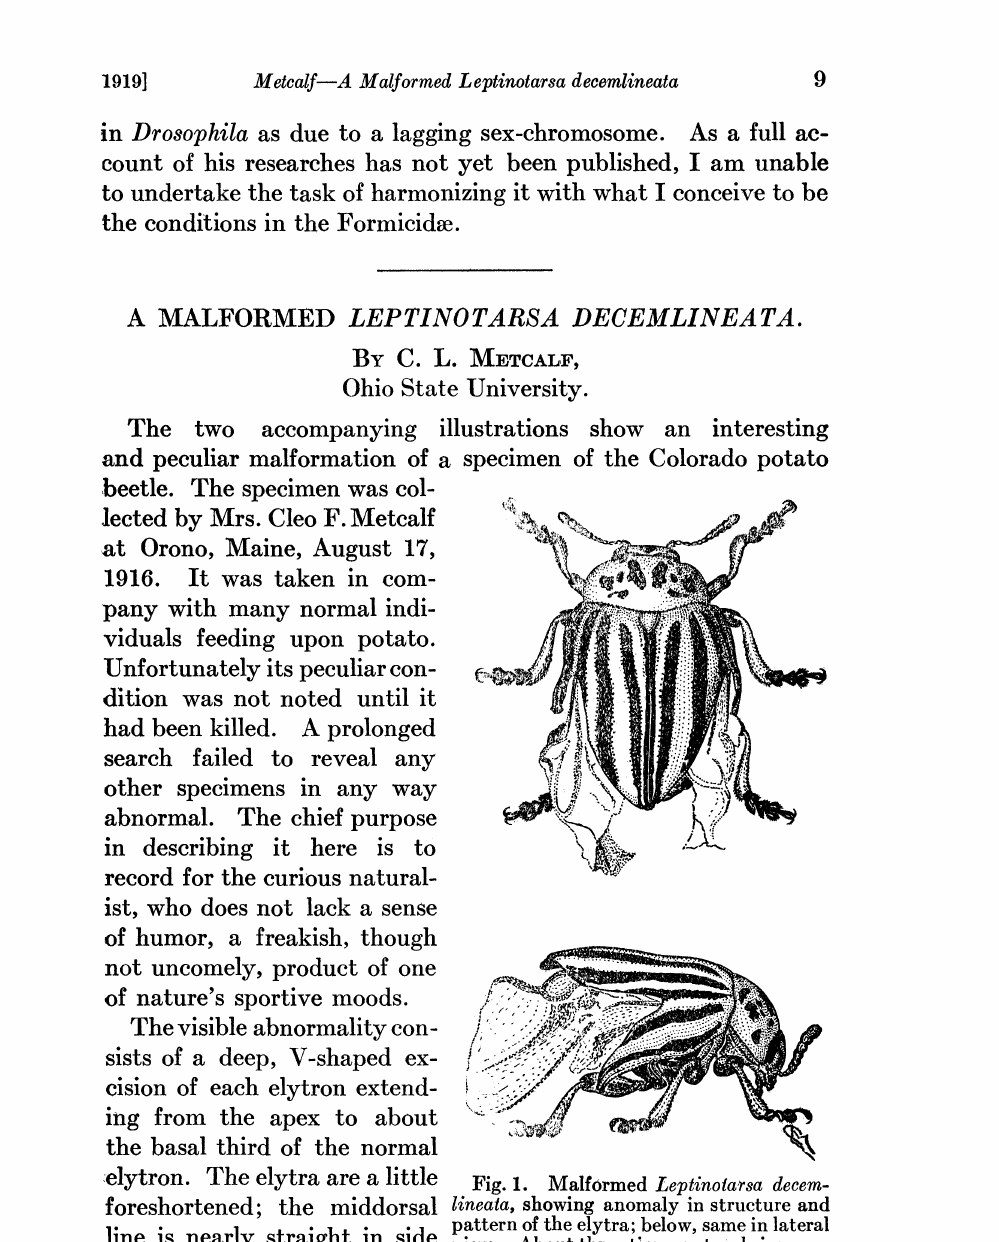
Fig. 1. Malformed Zeptinotarsa decem- foreshortened; the middorsal lineata, showing anomaly in structure and pattern of the elytra; below, same in lateral line is nearly straight in side view. About three times natural size. covering the tip of the abdomen is entirely wanting, leaving the abdomen exposed from